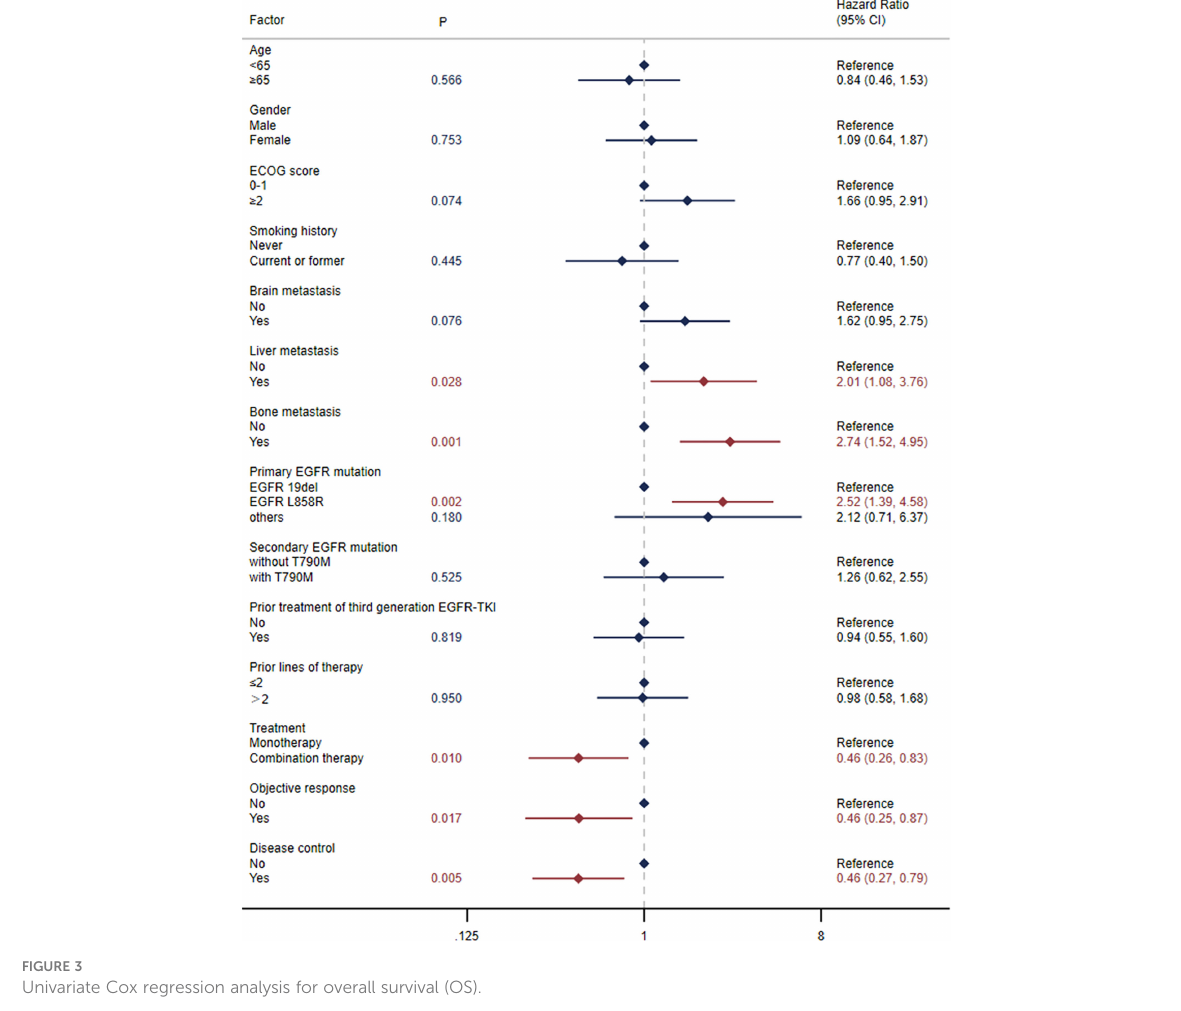
FIGURE 3 Univariate Cox regression analysis for overall survival (OS).